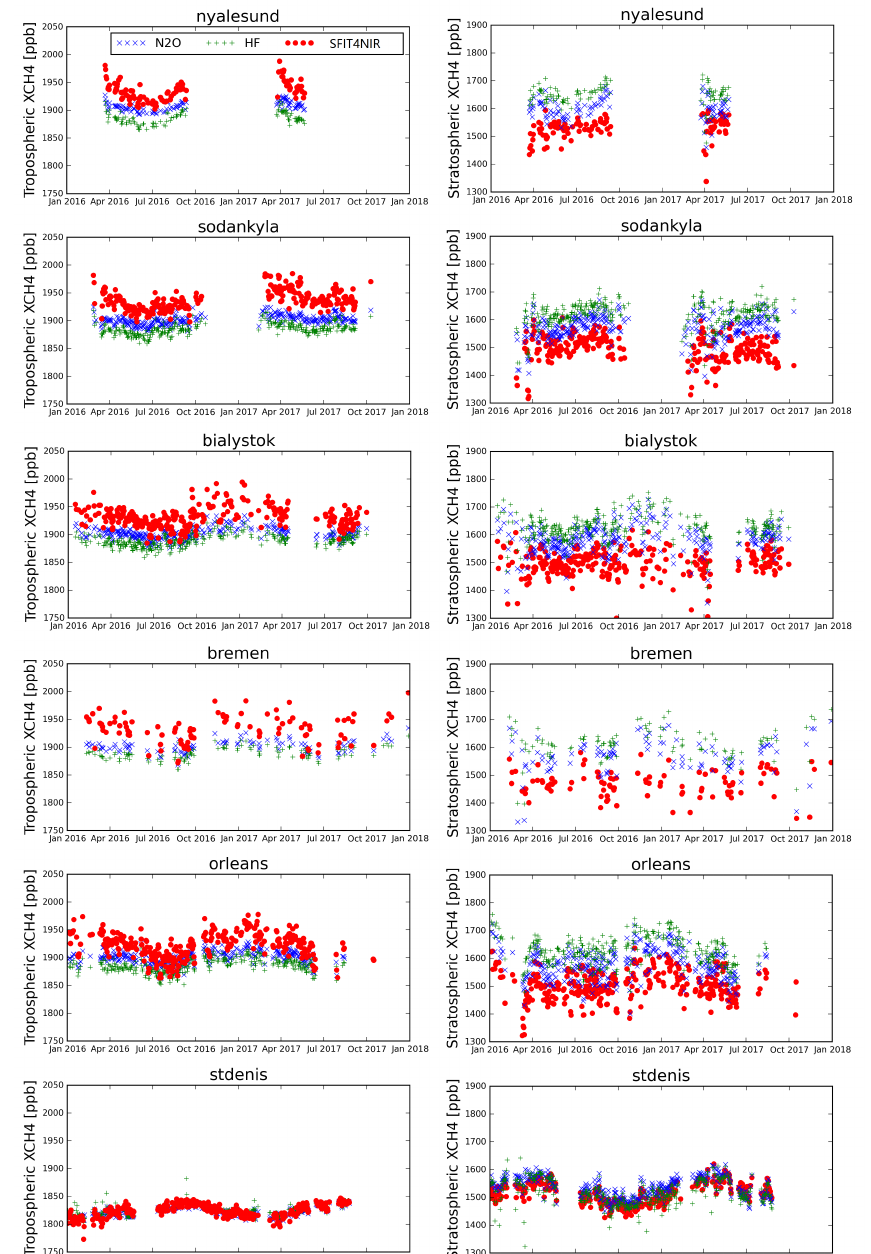
Figure 9. The time series of the tropospheric (left panels) and the stratospheric (right panels) co-located X CH SFIT4NIR and the proxy method (both N 2 O and HF) at the six TCCON